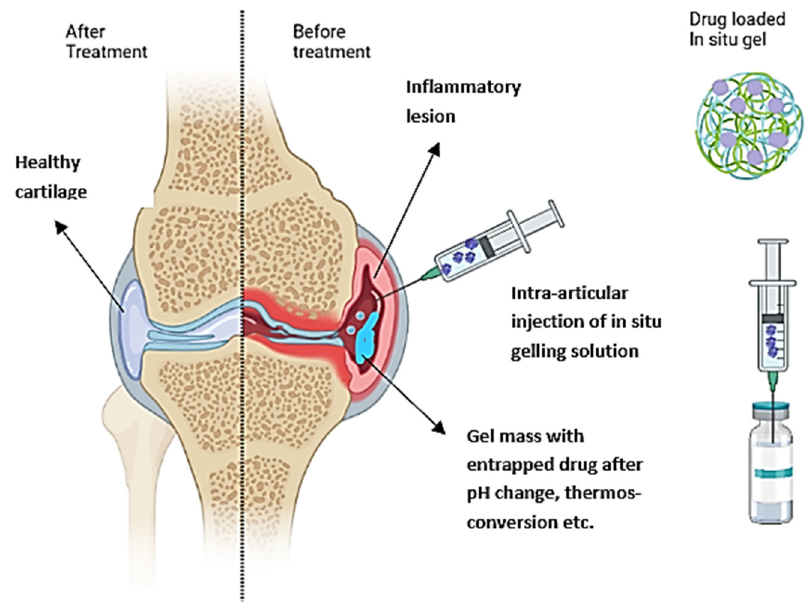
Figure 1. Schematic representation of the IA administration of an in situ gelling drug formulation into inflamed osteoarthritis (OA) joint and healthy tissue after treatment.